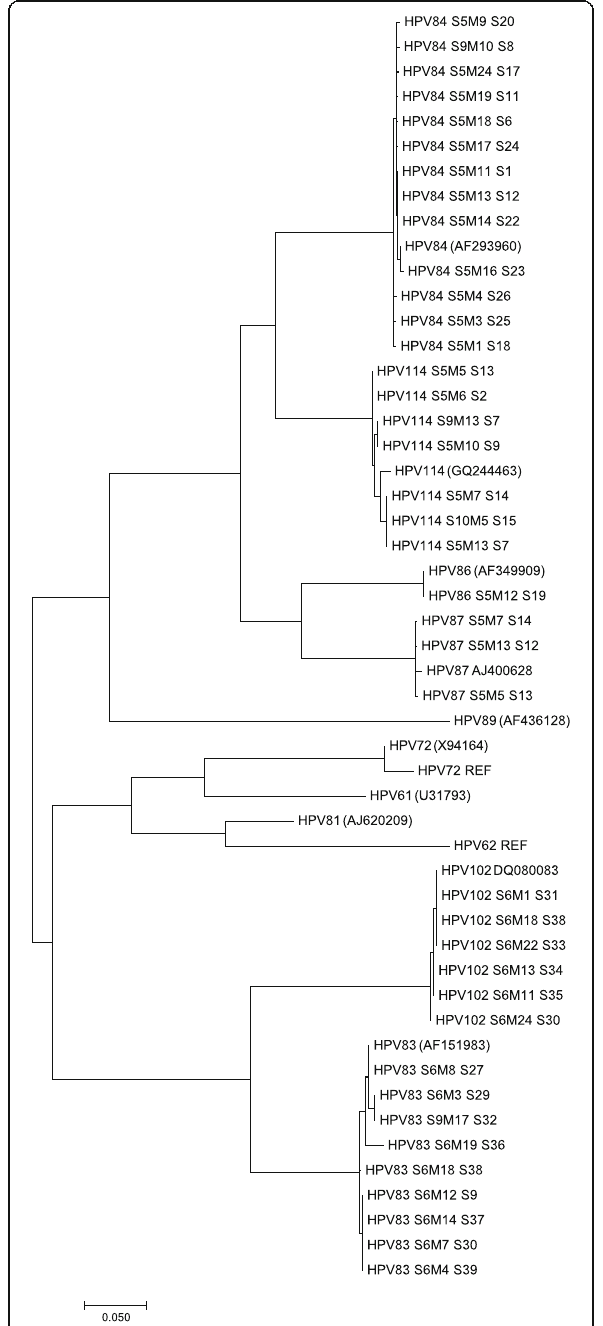
Fig. 2 Phylogenetic tree based on alpha-3 HPVs L1 sequences. The analysis involved the 11 reference HPVs from alpha-3 species (REF) and 39 L1 sequences from HPVs 83, 84, 86, 87, 102 and 114 that infect Mexican woman. The tree is drawn to scale, with branch lengths measured in the number of substitutions per